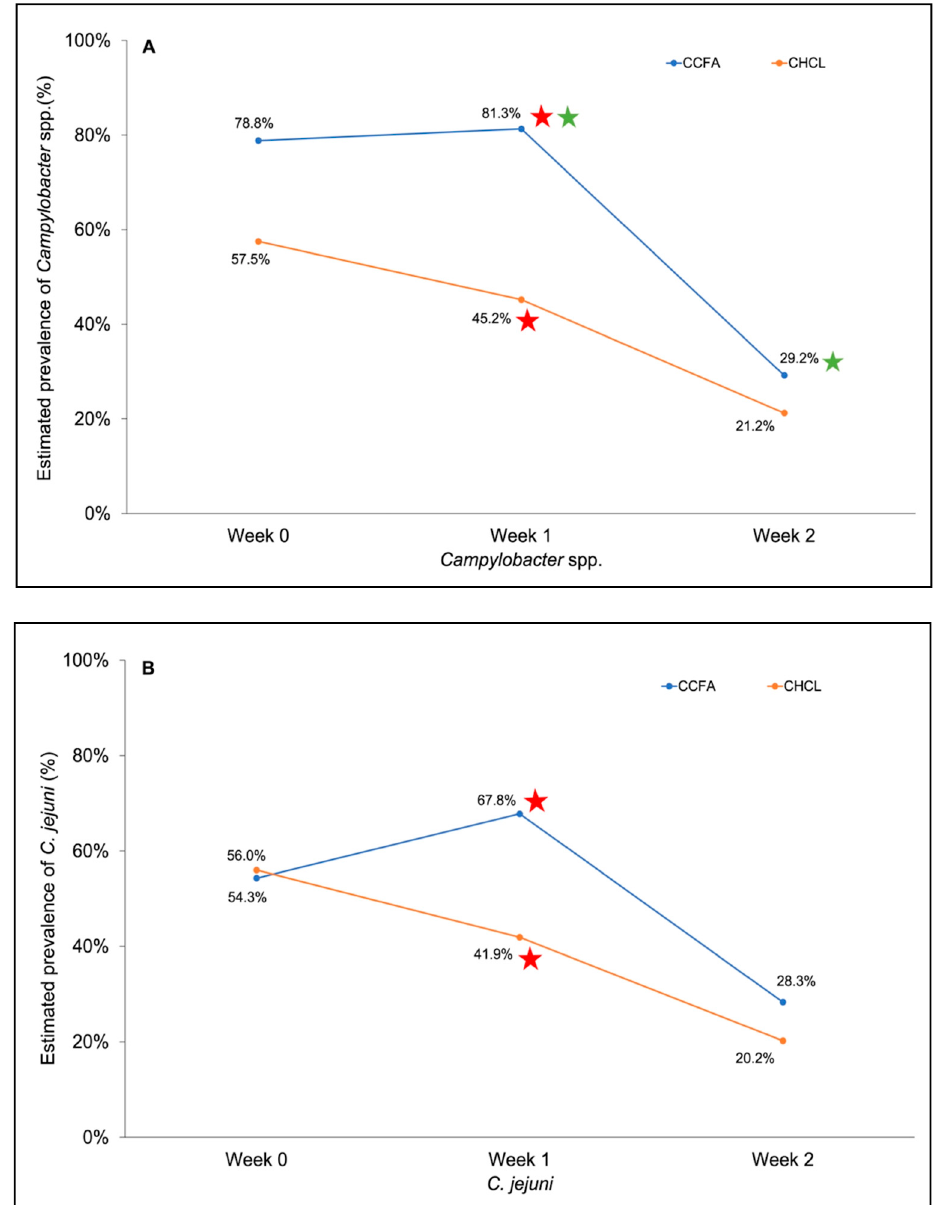
Figure 2. Estimated prevalence of ( A ) total Campylobacter spp. and ( B ) C. jejuni from the CCFA and CHCL groups. Red stars indicate a significant difference of estimated prevalence of Campylobacter spp. ( p = 0.0009) or C. jejuni ( p = 0.0184) between the CCFA and CHCL groups. Green stars indicate a significant difference ( p = 0.0108) of the estimated prevalence of Campylobacter spp. between week 1 and 2 under CCFA treatment. Weeks 0, 1 and 2 correspond to pre-treatment (0 h), 12 h to day 7, and day 8, respectively. Data are based on CCFA and CHCL samples processed at 37 °C. Estimated prevalence determinations were performed as described in Materials and Methods.